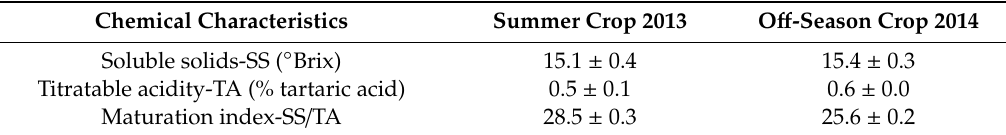
Table 3. Chemical characteristics of ‘BRS Melodia’ seedless grape grown under an annual double cropping system in a subtropical region. Summer season crop of 2013 and subsequent o ff -season crop of